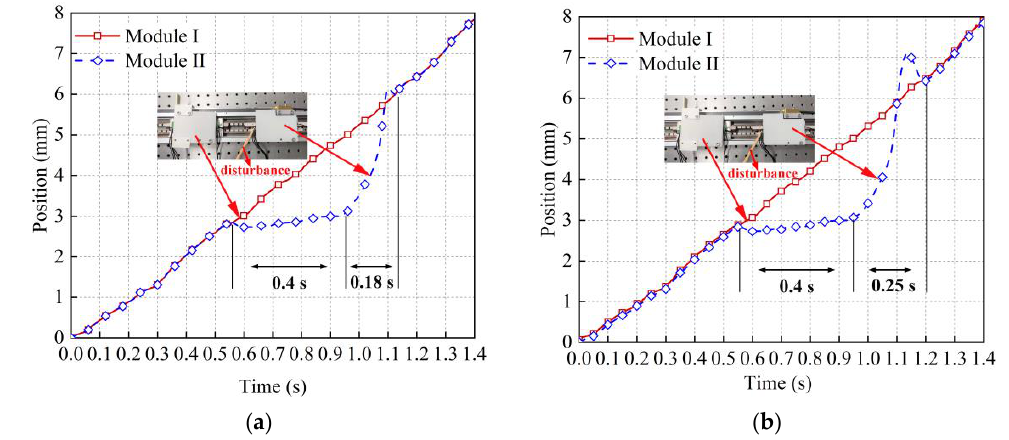
Figure 12. Position of Module I and Module II versus time under the external disturbance condition.